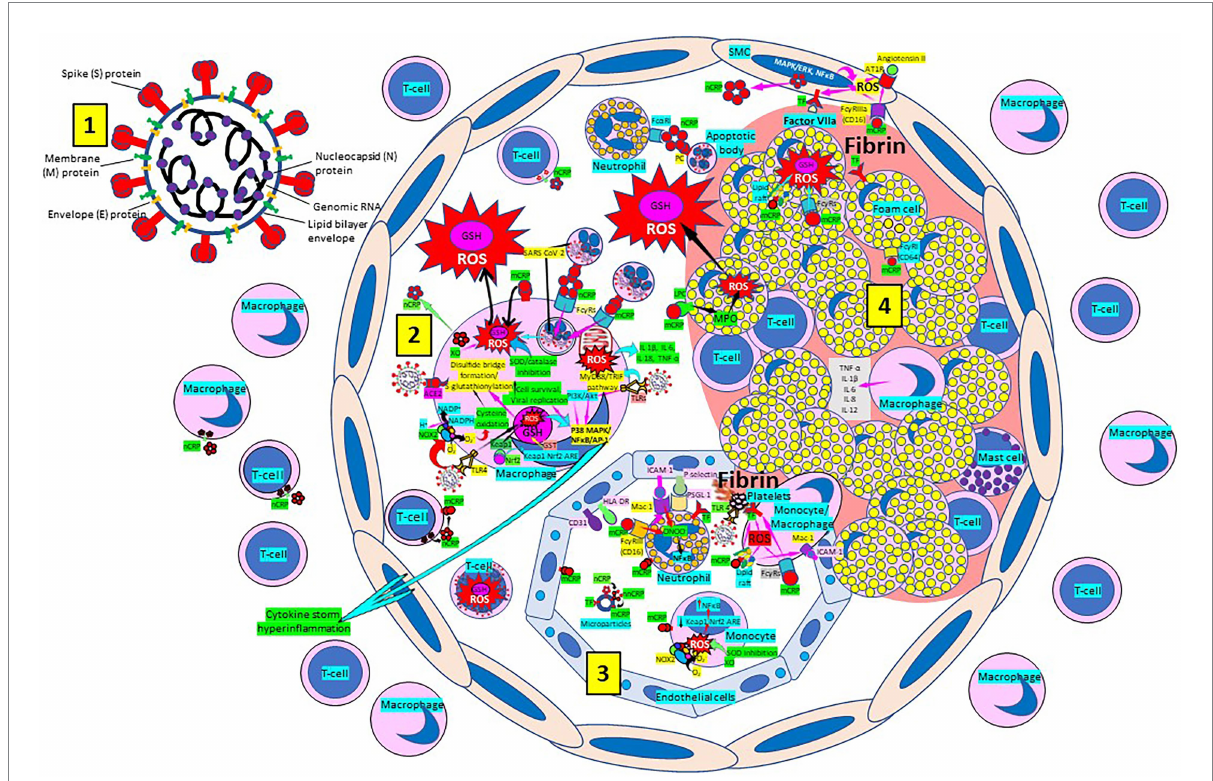
FIGURE 3 Severe acute respiratory syndrome coronavirus-2 (SARS-CoV-2) enhances oxidative stress and atherosclerosis progression. [1] SARS-CoV-2 structure. [2] SARS-CoV-2 viruses facilitate oxidative stress and inflammation in the arterial intima. Native C-reactive protein (nCRP), a marker of severe SARS-CoV-2 produced in liver, macrophages, lymphocytes, smooth muscle cells (SMC) and other cells, promotes inflammation through monomeric CRP (mCRP) enhancing intimal oxidative stress. SARS-CoV-2 binds macrophage toll-like receptor (TLR) 4 and facilitates nicotinamide adenine dinucleotide phosphate (NADP) H oxidase 2 (Nox2) activity and superoxide (O 2 − ) production causing cysteine oxidation, disulfide bridge formation and S-glutathionylation. Xanthine oxidase (XO) and inhibition of superoxide dismutase (SOD)/catalase further facilitate O 2 − cellular activity and ROS generation. SARS-CoV-2 can bind TLRs 2 and 4 and activate transcription factors like nuclear factor (NF)- κ B facilitating cytokine storm and hyperinflammation. Excessive mitochondrial reactive oxygen species (ROS) generation further enhances cytokine production. CRP (nCRP, mCRP) can facilitate macrophage and neutrophil uptake of SARS-CoV-2-infected apoptotic cells through Fc γ and Fc α receptors, respectively (FcRs). Oxidative stress also activates the Kelch-like ECH-associated protein 1 (Keap1)-Nuclear factor erythroid 2-related factor2 (Nrf2)-antioxidant response element (ARE) redox regulator pathway in monocytes (see [3] and macrophages, releasing Nrf2 to regulate the expression of genes that control antioxidant enzymes like glutathione S-transferase (GST)), facilitating glutathione (GSH) activity. Macrophages, Tlymphocytes, neutrophils and SMCs can generate mCRP increasing inflammation. [3] Monocytes, macrophages, neutrophils, endothelial cells and microparticles can generate mCRP, increase O 2 − and ROS formation and reactive nitrogen species like peroxinitrite (ONOO − ), and tissue factor (TF) expression enhancing oxidation, inflammation and thrombosis. TLR 4-mediated SARS-CoV-2-binding to platelets promotes thrombosis, mCRP binding to lipid rafts and Fc γ Rs enhances inflammation and endothelial activation allows intimal cell migration. [4] Foam cells and smooth muscle cells associated with atherosclerotic plaques enhance ROS formation, cytokine release and tissue factor (TF)-mediated fibrin deposition. MAPK/ERK, mitogen-activated protein kinase/extracellular signal-regulated kinase; AT1R, Angiotensin II type 1 receptor; PC, phosphorylcholine; LPC, lysophosphatidylcholine; MPO, myeloperoxidase; nnCRP, non-native CRP; TNF, tumor necrosis factor; IL, interleukin; ACE, angiotensin converting enzyme; MyD88/TRIF, myeloid differentiation primary response88/TIR-domain-containing adapter-inducing interferon- β ; PI3K/Akt, phosphatidylinositol-3-kinase/protein kinase B; AP-1, activator protein 1; CD31, cluster of differentiation 31; ICAM-1, intercellular adhesion molecule-1; Mac-1, macrophage-1 antigen; PSGL-1, P-selectin glycoprotein ligand-1; HLA- DR, Human Leukocyte Antigen – DR